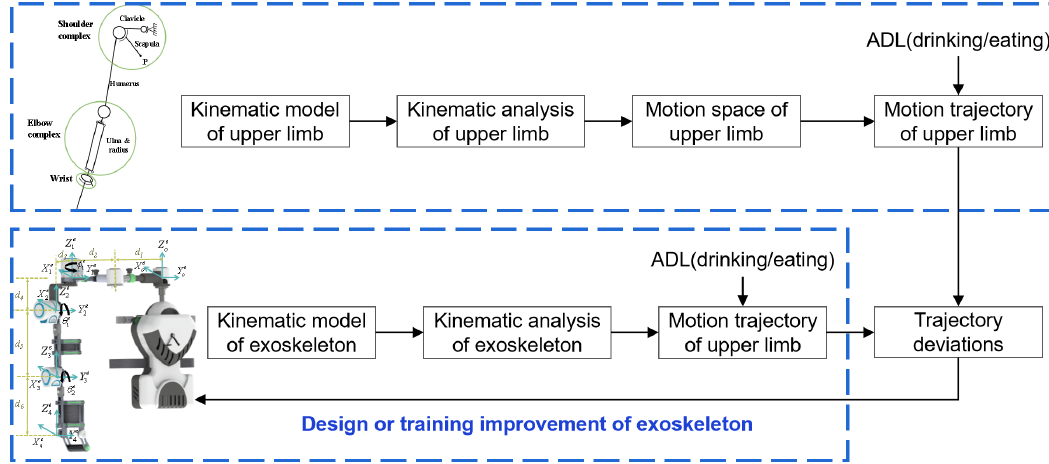
Figure 11. A schematic representation of the evaluation method.